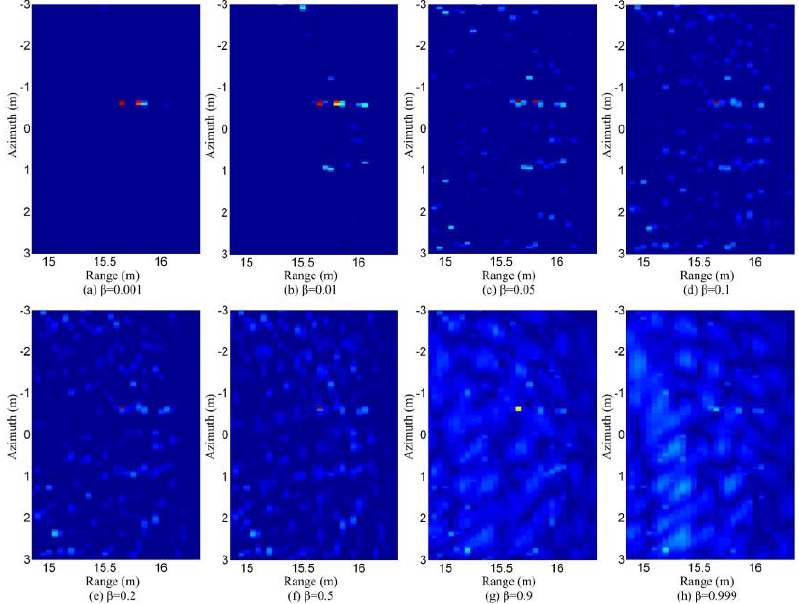
Figure 14. Reconstruction results in clutter environment with different parameters (taken from [80]).